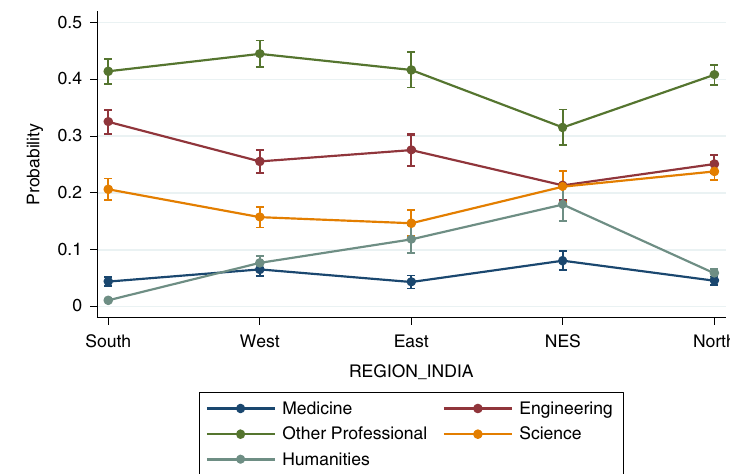
Figure 2. Predicted average probability of subject choice by